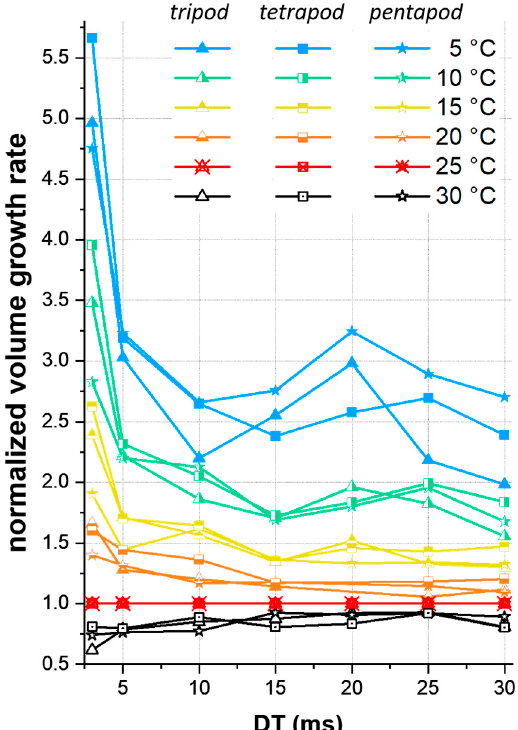
Figure 3. Volume growth rates of multipod geometries fabricated at different T S , normalized to the volume growth rate at 25 ◦ C (red dataset). The triangles, rectangles and stars indicate tri-, tetra- and pentapod structures, respectively.